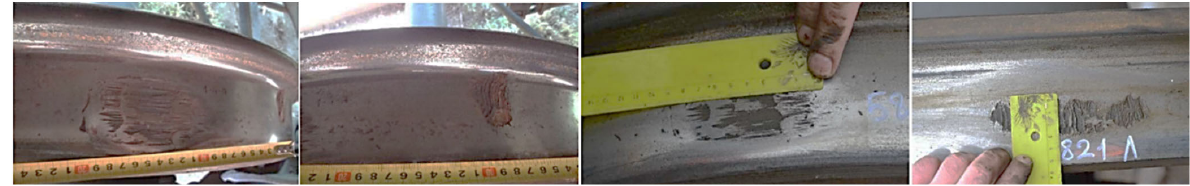
Figure 19. Wheel damage—flat and cracks. Examples of the distribution of vertical forces caused by wheel damage (flat and cracks) in rail cross-sections are provided in the literature [12]. Vertical force maximal values of loaded wagon are given in Figure 20.